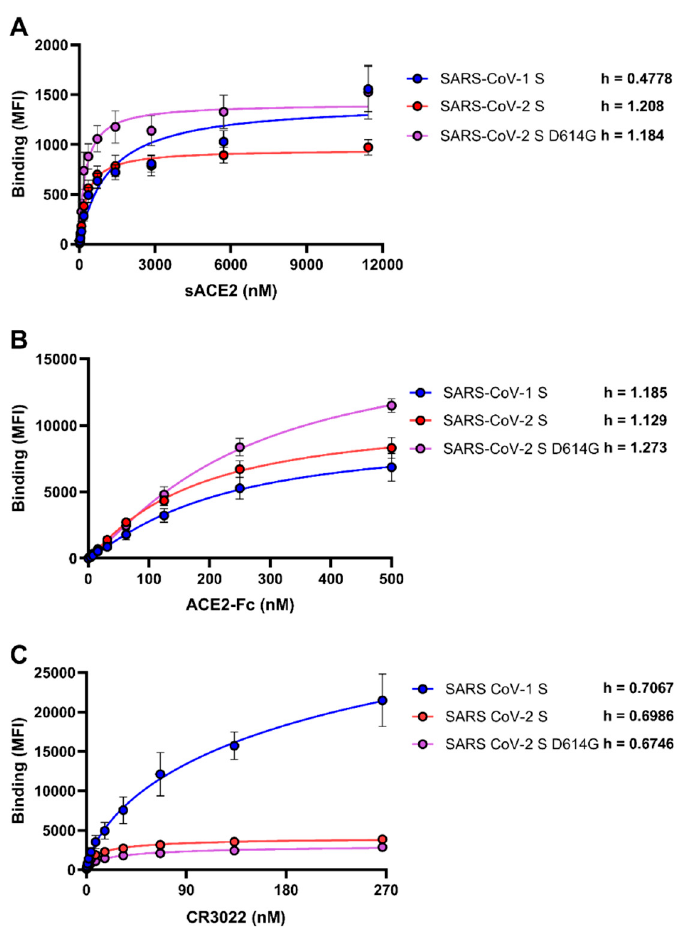
Figure 1. Differences between severe acute respiratory syndrome virus 1 (SARS-CoV-1) and severe acute respiratory syndrome virus 2 (SARS-CoV-2) spikes in their abilities to engage soluble monomeric angiotensin-converting enzyme 2 (sACE2), ACE2-Fc, and CR3022. The binding of ( A ) sACE2, ( B ) ACE2-Fc, and ( C ) CR3022 to SARS-CoV-1 or SARS-CoV-2 (wt or D614G) spikes expressed on the cell surface were measured by flow cytometry. Increasing concentrations of each ligand were incubated with Spike-expressing cells as described in the Material and Methods. Means ± SEM derived from at least three independent experiments are shown. The Hill coefficient was determined using GraphPad software.